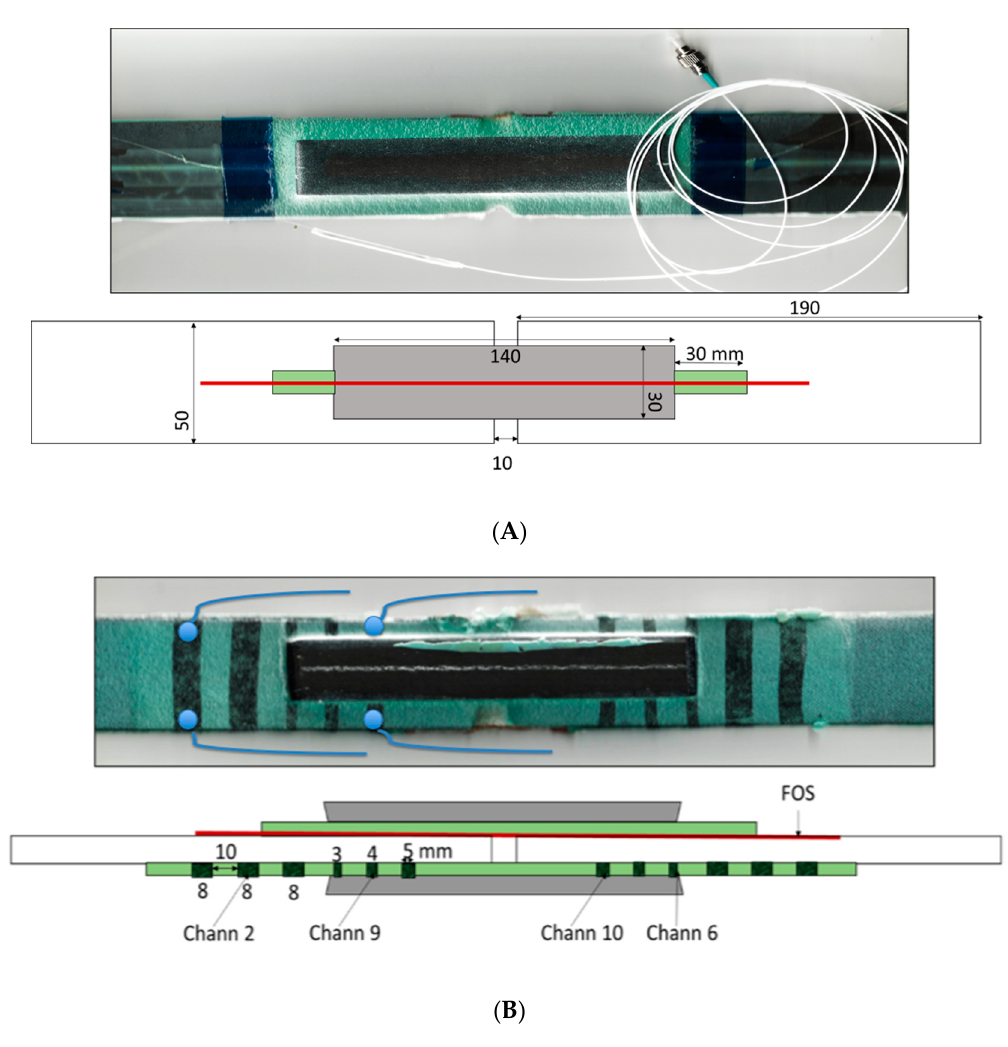
Figure 4. ( A ) Double lap bonded joint specimen.Photograph of one side of the specimen, constructed with a longitudinally aligned optical fiber. ( B ) Double lap bonded joint specimen. Photograph of the other side of the specimen, where the transverse black strips are CNT-doped regions on the green adhesive. Copper wires were used as electrodes, fixed with silver conductive paint, and sealed with an adhesive layer to avoid environmental issues, as sketched in the